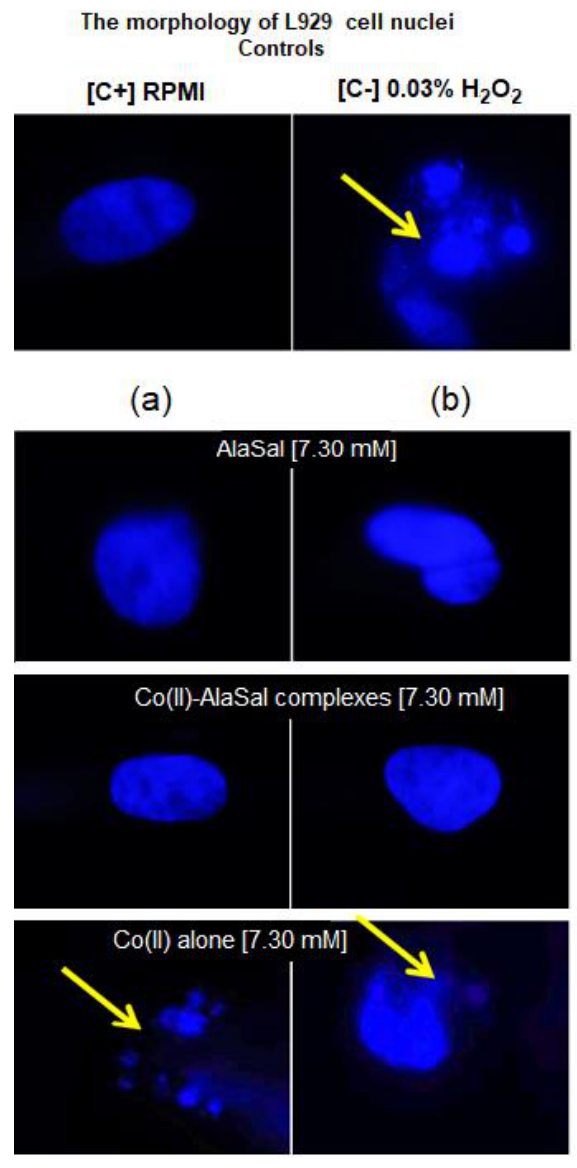
Figure 7. Microscopic images of L929 cells with a sign of cell nuclei damage. Cell cultures in complete RMPI-1640 medium (cRPMI) were used as positive control (C + ): cells with no sign of cell nuclei damage; cells treated with 0.03% H 2 O 2 were used as negative control (C − ): cells with DNA damage. L929 cells stimulated with selected compounds: ( a ) solution prepared freshly or ( b ) solution stored for two weeks. The morphology of cell nuclei was assessed by 4′,6-diamidino-2-phenylindole (DAPI) staining. Samples were viewed under a fluorescent microscope (Axio Scope A1, Zeiss).